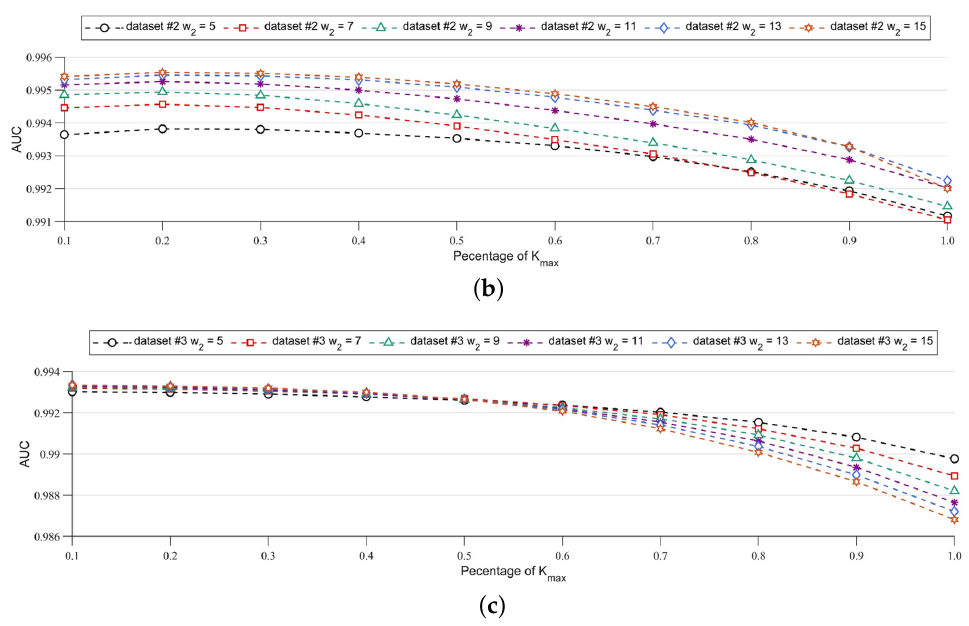
Figure 12. The AUC curves under different K on Datasets #1/2/3. ( a ) AUC curves on Dataset #1. ( b ) AUC curves on Dataset #2. ( c ) AUC curves on Dataset #3.